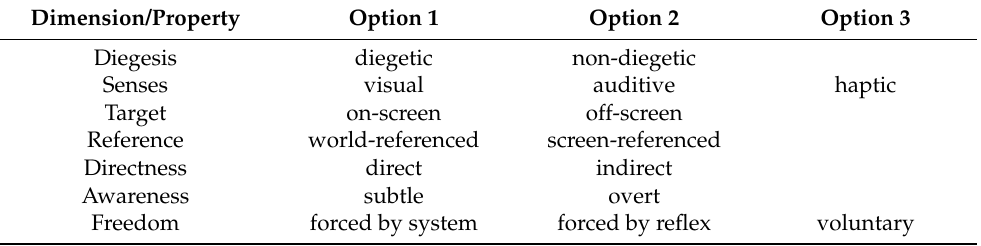
Table 3. The table shows the different dimensions of guiding methods and possible values.